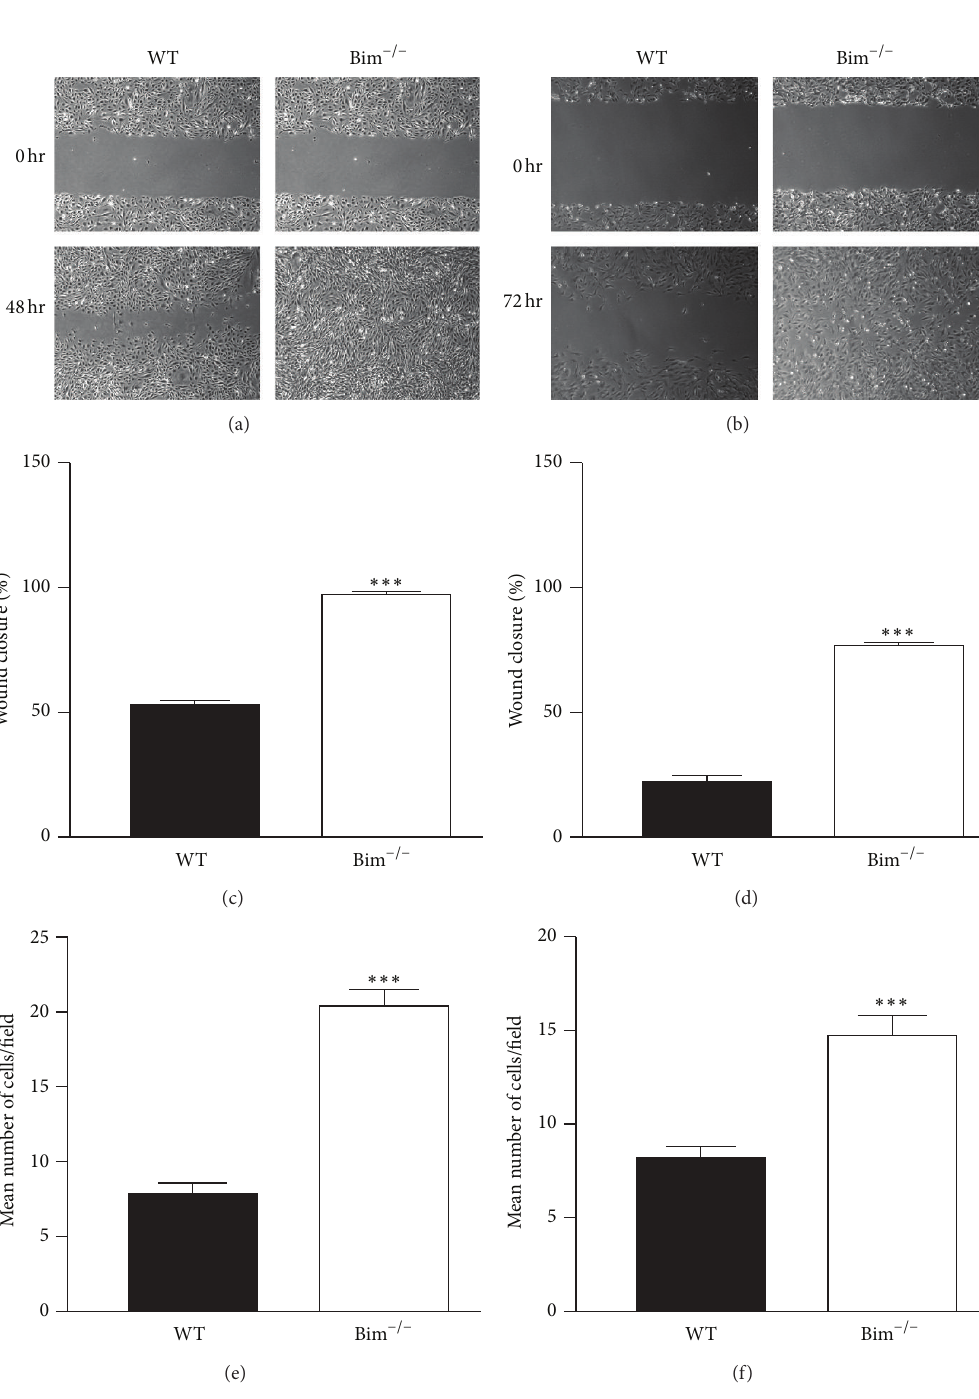
Figure 3: Bim −/− retinal endothelial cells and pericytes demonstrate increased migration. Cell migration was determined by the scratch wounding of retinal endothelial cells (panel (a)) or pericytes (panel (b)) monolayers, and wound closure was monitored using a phase microscope in digital format at low magnification ( × 40). A representative experiment is shown here. Please note that wild-type vascular cells migrate slower than Bim −/− cells. The quantitative assessment of the data is shown in panels (c) and (d). Transwell assays were performed with wild-type and Bim −/− retinal endothelial cells (panel (e)) and pericytes (panel (f)). These experiments were repeated twice with similar results ( ∗∗∗ 𝑃 < 0.001